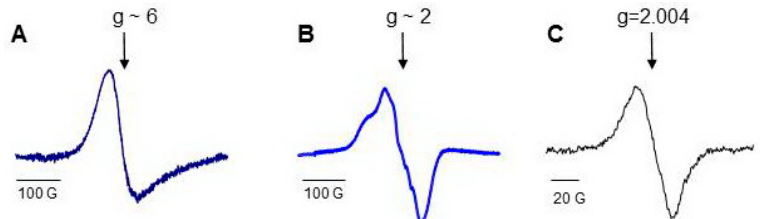
Figure 4. Low-temperature EPR (77 K) spectra of Hb and Mb [69]: ( A ) low field EPR signal of ferric myoglobin; ( B ) a typical LT EPR signal of heme-nitrosylated Hb(II); ( C ) spectrum of protein-derived (tyrosyl) radicals measured in 30 s after addition of H 2 O 2 to Hb.